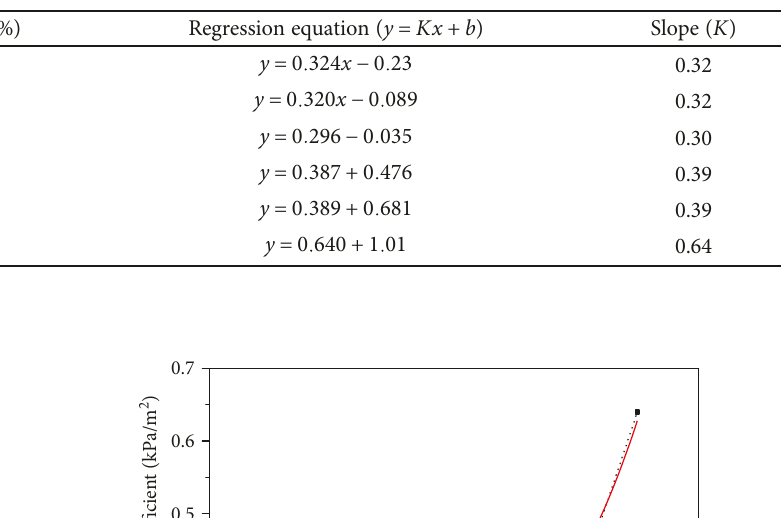
Table 2: Linear relationship curve ( y = kx + b ) of PGBS.